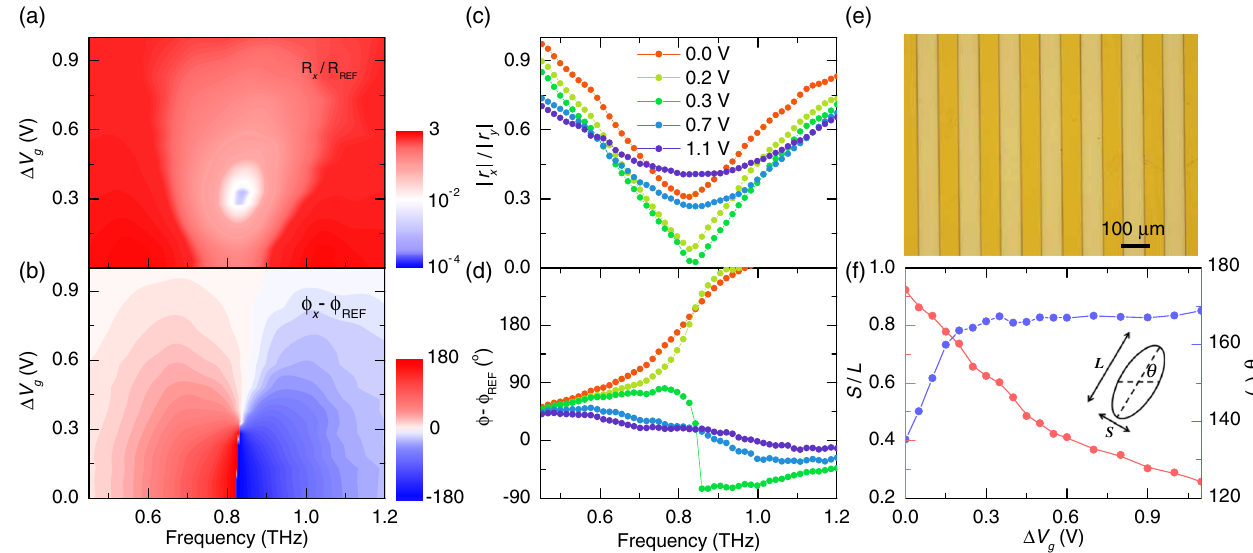
FIG. 5. A gate-tunable THz polarizer. (a) A reflectance modulation and (b) reflection phase modulation as a function of the gate voltage and frequency measured on the polarizer [shown in (e)]. The incident THz wave is polarized perpendicular to the stripes of the polarizer. (c) The reflection amplitude ratio and (d) phase difference between waves with polarizations in the x and y directions measured as a function of the frequency at different gate voltages. Both parameters are effectively modulated by the gate voltage. (e) An optical image of the polarizer. The stripes have a width of 60 μ m, and they are spaced 60 μ m apart. (f) The polarization state (see inset) of the reflected THz wave, characterized by the elliptical axis ratio ( S=L , red curve) and the rotation angle θ (blue curve), measured as a function of the gate voltage. The working frequency is 0.63 THz. The gate causes a drastic modulation of the polarization